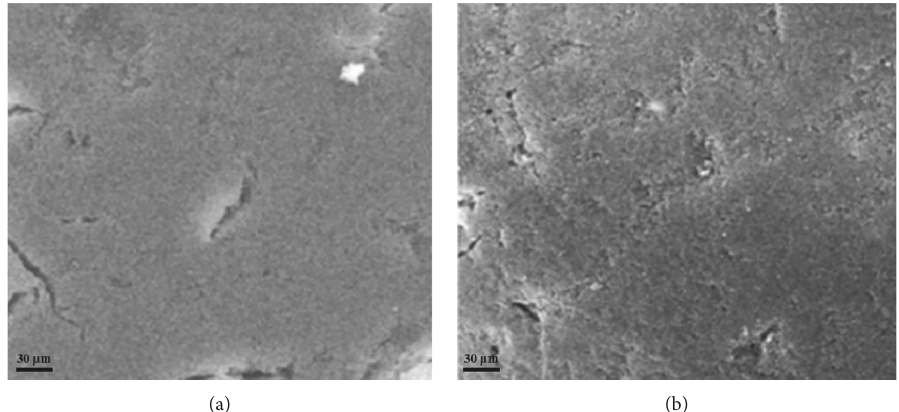
Figure 4: The scanning electron micrographs of (a) CMCPS resin (b) MIPs.